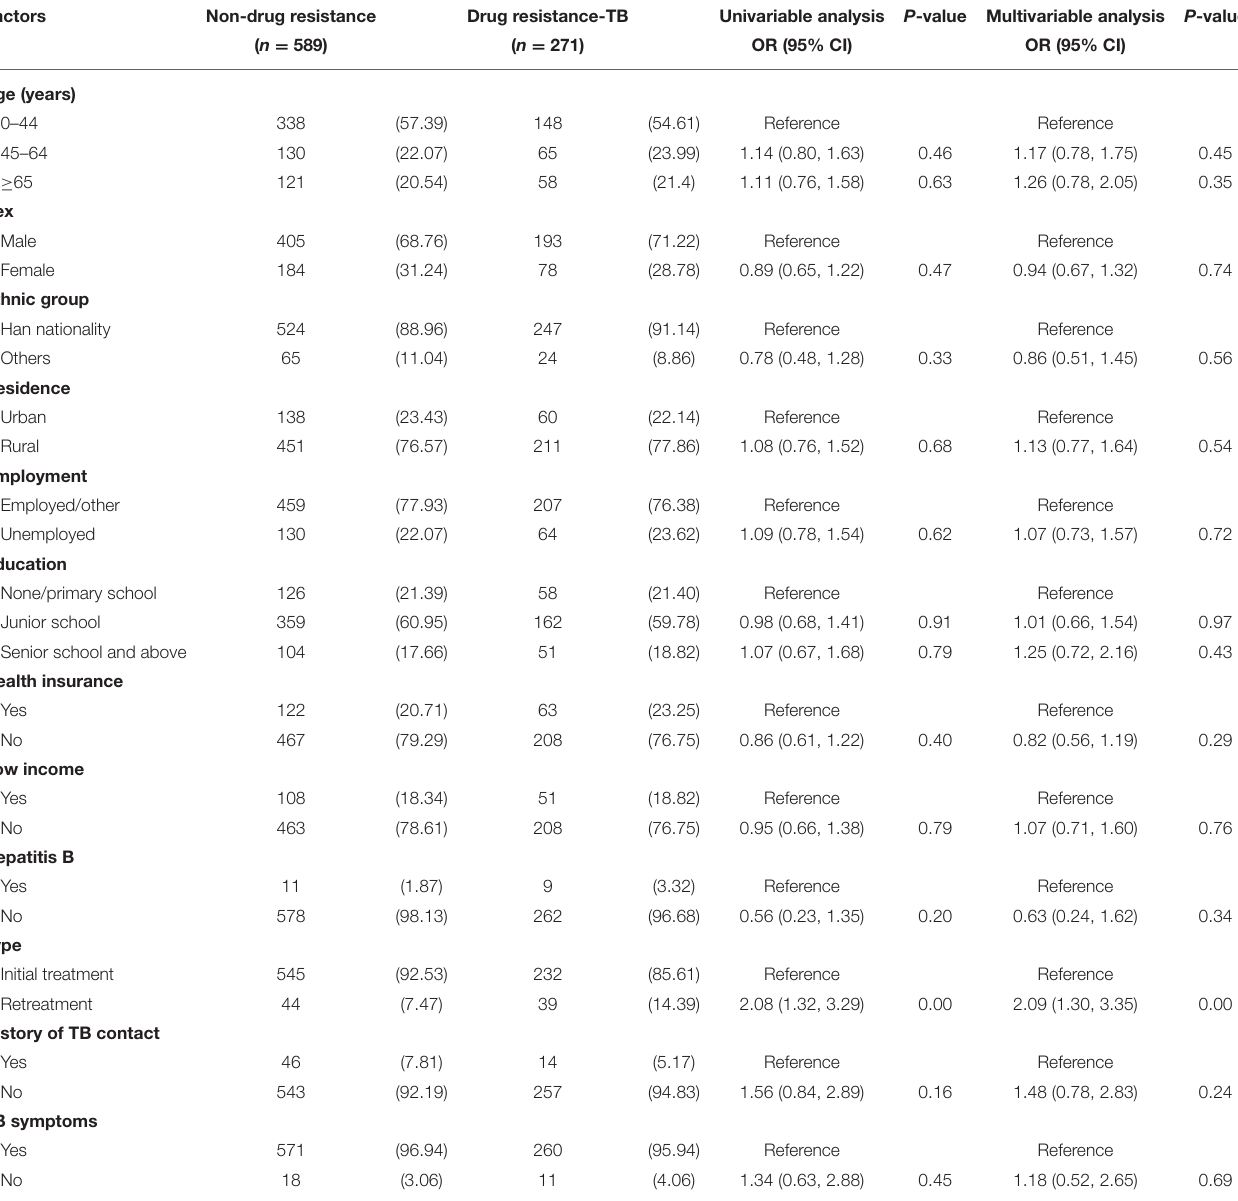
TABLE 4 | Risk factors of drug resistance among TB-no DM cases.